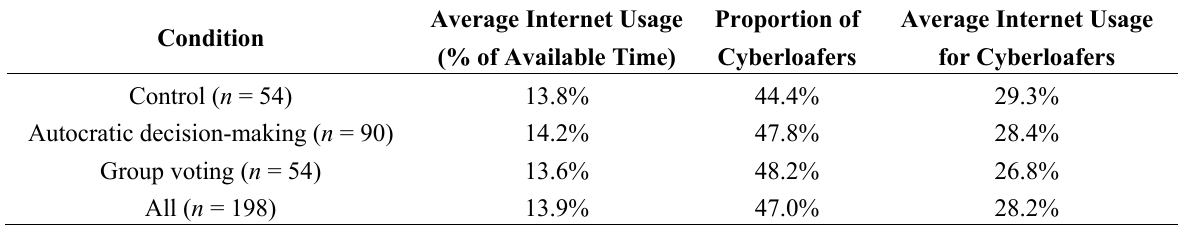
Table 2. Individual Internet usage in the first two periods across conditions (all workers, excluding the monitor).